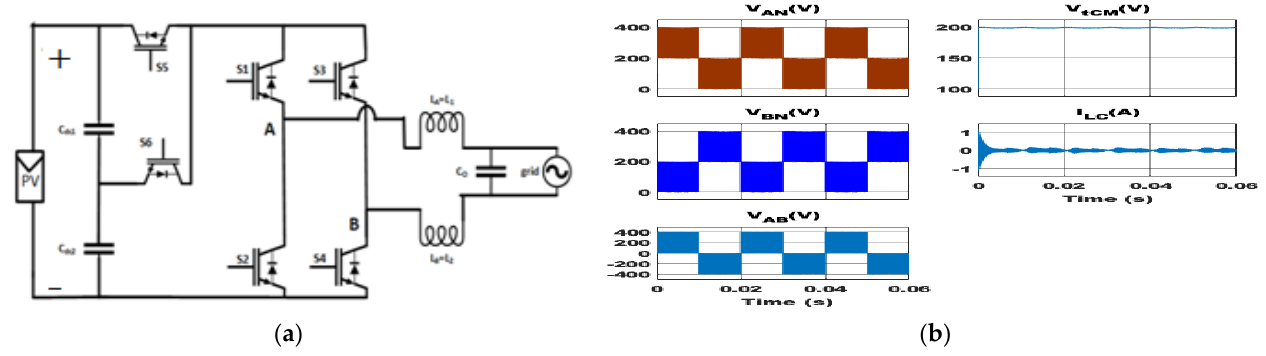
Figure 13. OH5 topology: ( a ) circuit structure; ( b ) simulation results.